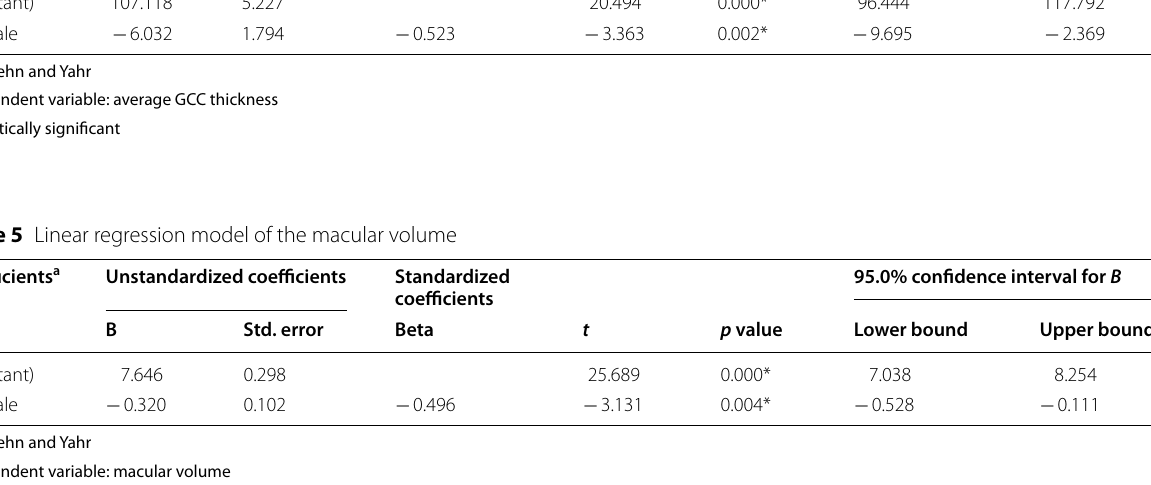
HY Hoehn and Yahr a Dependent variable: macular